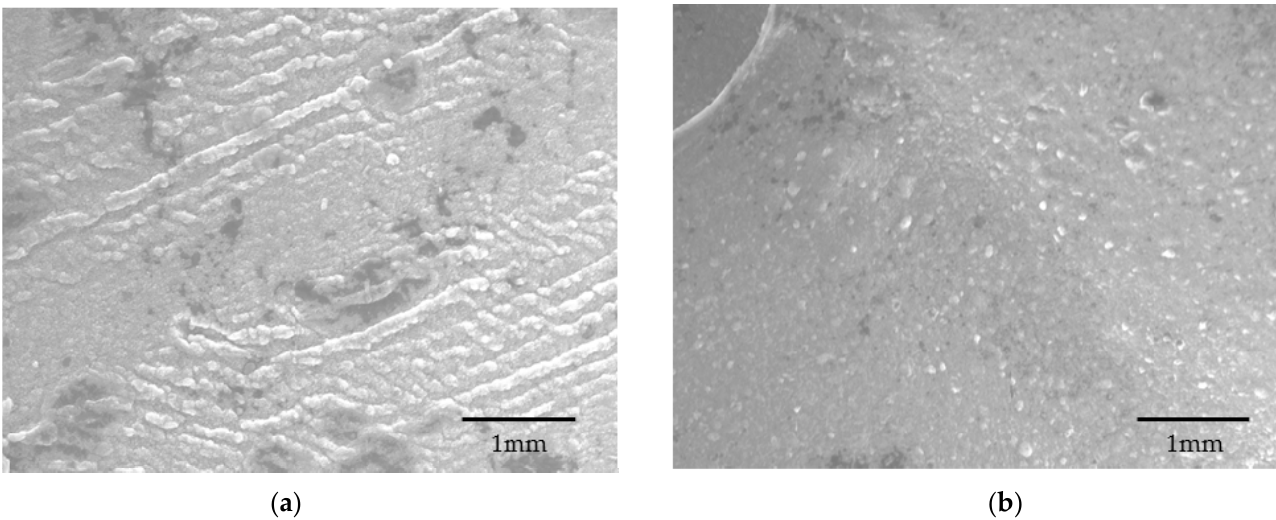
Figure 8. Microscopic evaluation of capsule surfaces. ( a ) Alginate capsule without MMT and ( b ) alginate capsule with MMT. The imaging was performed at ×500 magnification.